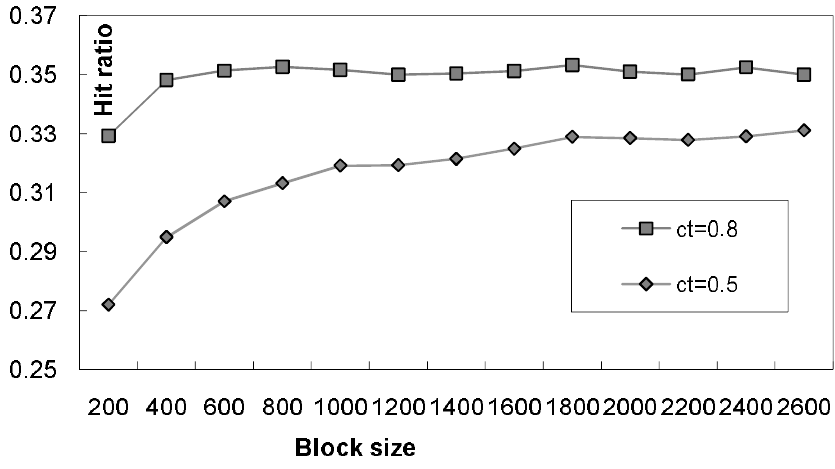
Figure 7. The hit ratio of the look-up table under different correlation block